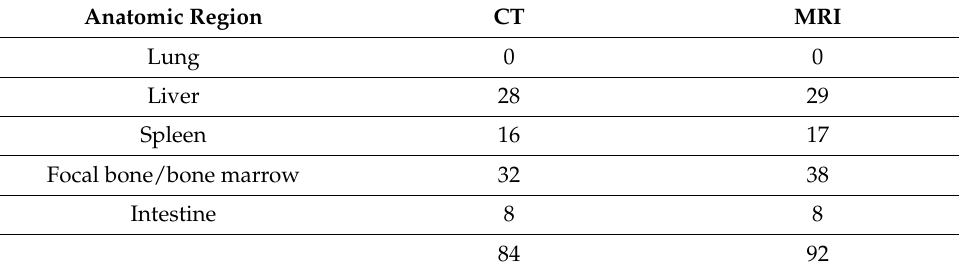
Table 2. Extra-nodal lesion detected by CT and MRI classified by localization.